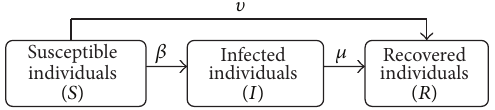
Figure 5: The scheme of the susceptible-infected-recovered model with vaccination (6).